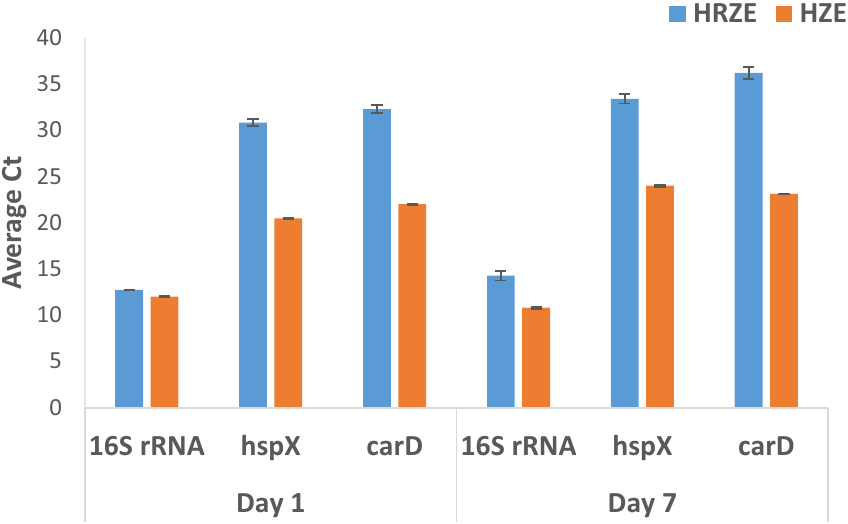
Figure 6. Average qRTPCR cycle threshold values for 16S rRNA, and hspX and carD mRNAs for H37Rv cells treated with isoniazid, pyrazinamide and ethambutol either with rifampin (HRZE) or without rifampin (HZE). RNA was extracted from an equivalent number of cells based on CFU after treatment with HRZE or HZE. Analyses were performed at day 1 and day 7 after addition of drugs. Results for 16S rRNA primer set ‘F1 R1 0.1 µM’ are